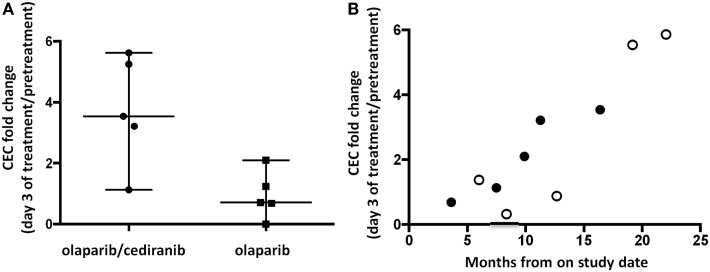
Circulating endothelial cells (CEC) and circulating endothelial progenitor cells (CEP). (A) Patients receiving olaparib/cediranib had a larger fold increase in CEC compared to olaparib alone during treatment (p = 0.032). (B) The fold increase in CEC on day 3 was associated with PFS duration in all patients (R2 = 0.77, 95% CI 0.55–0.97, p < 0.001) when reporting values on a patient-by-patient basis. The open dots represent patients whose times at risk were censored on the date of their last contact and were last reported alive and progression-free. This observed pattern may not retain the linear relationship as time passes.